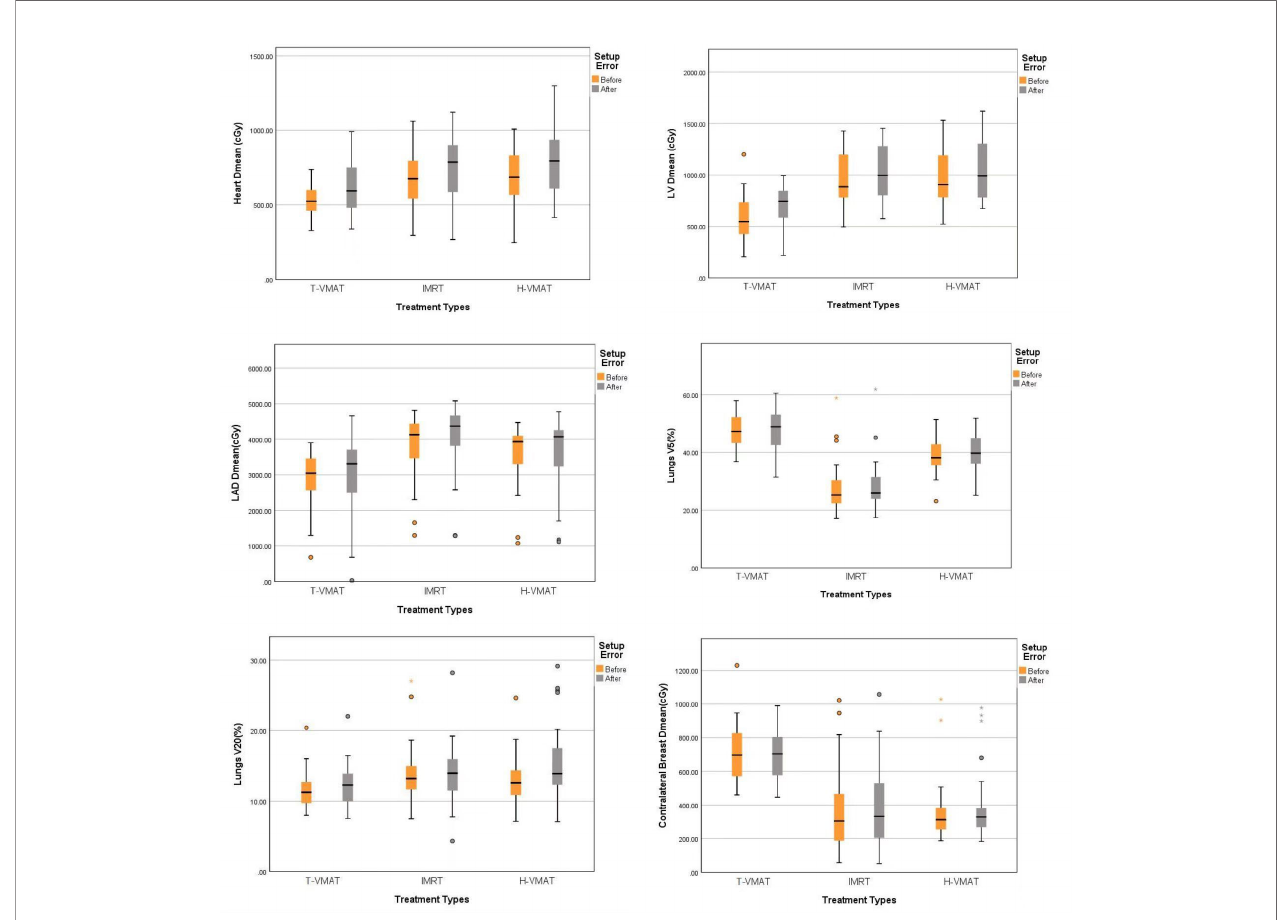
FIGURE 5 | Box-whisker plot of dosimetry parameters with error bars:Heart Dmean, Left ventricle Dmean, Left anterior Dmean, Lungs V5, Lungs V20, Contralateral breast Dmean. Each fi gures show the dose changes of each OARs before and after the recalculation of setup error. Gray bars represent the accumulated dose after the consideration of setup error, and yellow bars represent the dose not considered of setup error. The points in the graph represent outliers, the black horizontal lines in the fi gures represent the average of each